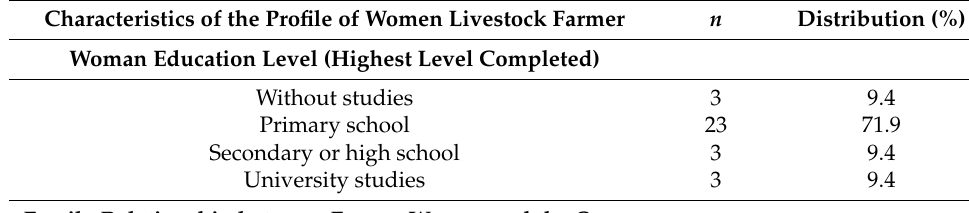
Table 3. Characteristics of the profile of livestock farmer women. Characteristics of the Profile of Women Livestock Farmer n Distribution